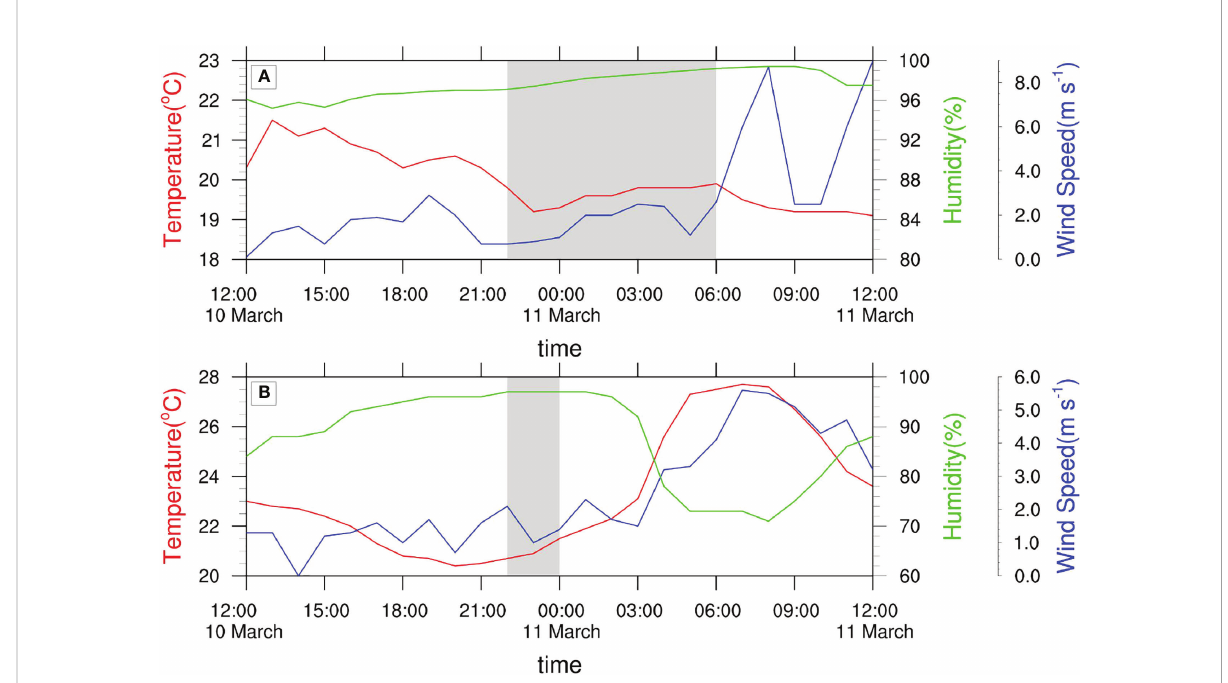
FIGURE 2 Time series of wind speed, air temperature, humidity, and fog duration (gray shaded areas) for station (A) and station (B) in Figure